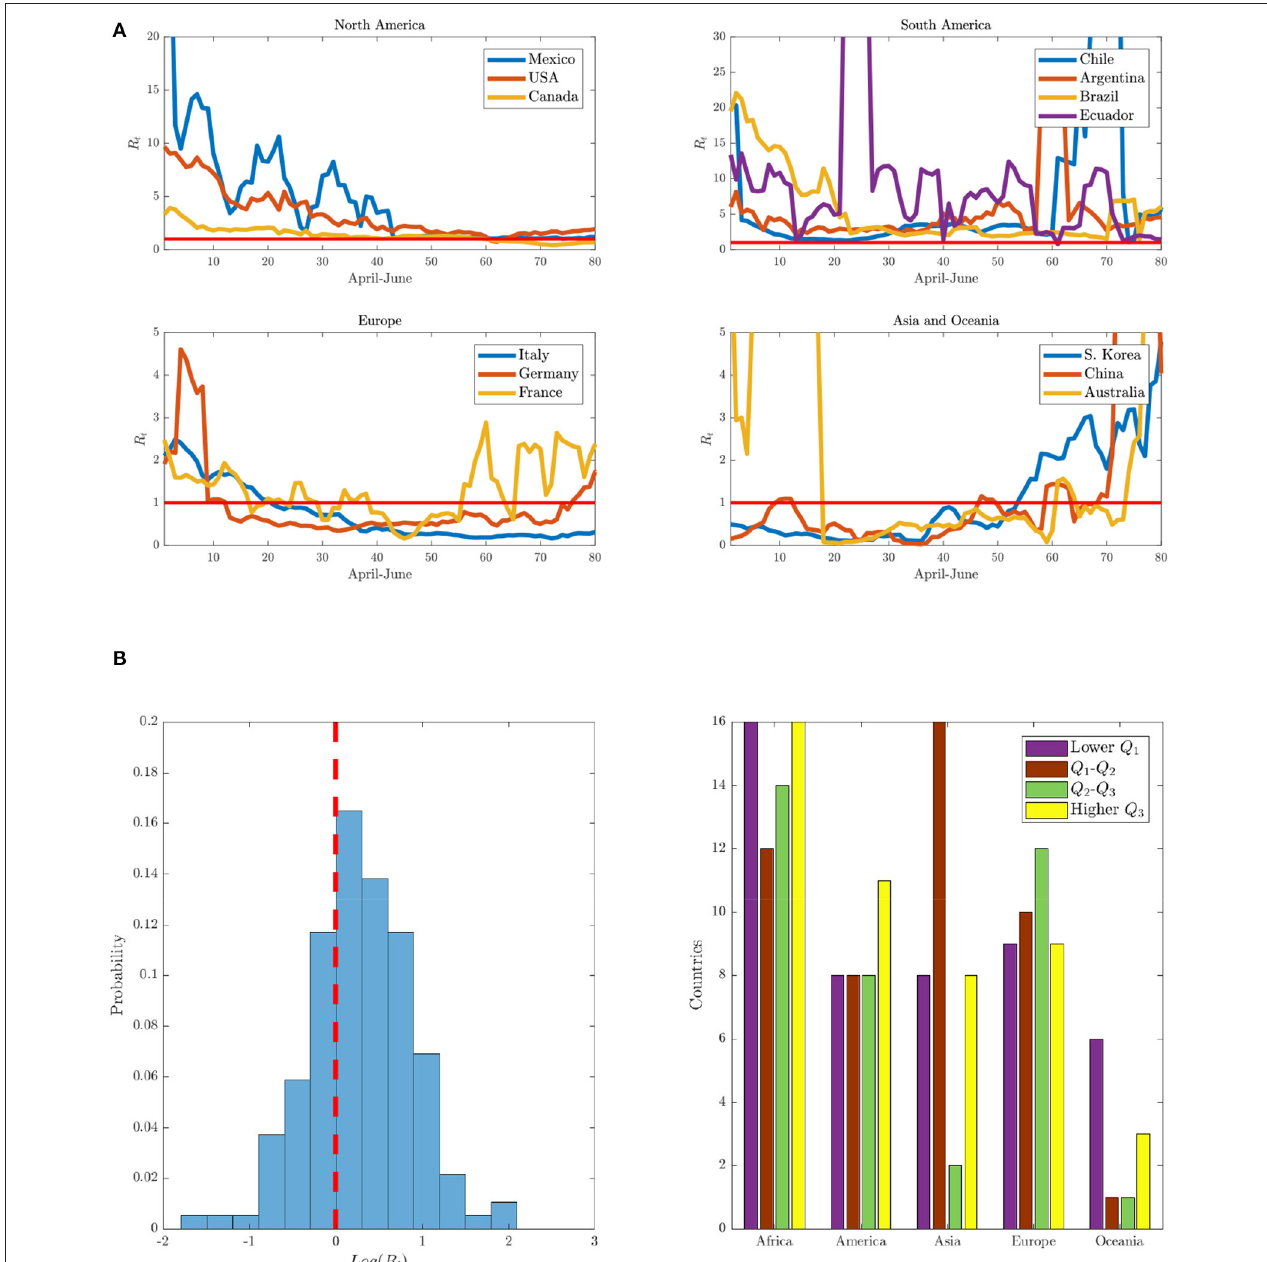
FIGURE 3 | Analysis of spread of COVID-19. (A) Shows the R t trends for different countries during the spread of COVID-19, separated by continent. (B) (Left) Shows the distribution of R t during the last day of registration (June 21) and (right), the number of countries our models successfully forecast, per continent. Several countries above the Q3 quartile exhibit R t values above 4.6, denoting a lack of relevant control over the SARS-CoV-2 outbreak. All data were obtained from Dong et al.